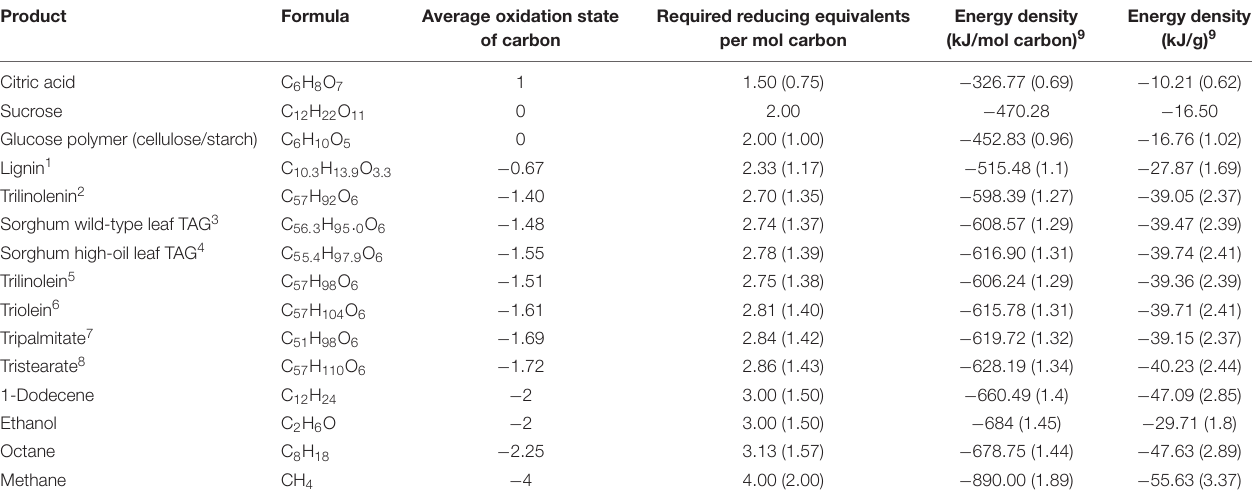
TABLE 2 | Energetic demands in reducing equivalents and energy density for theoretical products of photosynthesis.